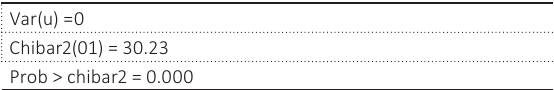
Table 5. Breusch and Pagan Lagrangian multiplier test for random